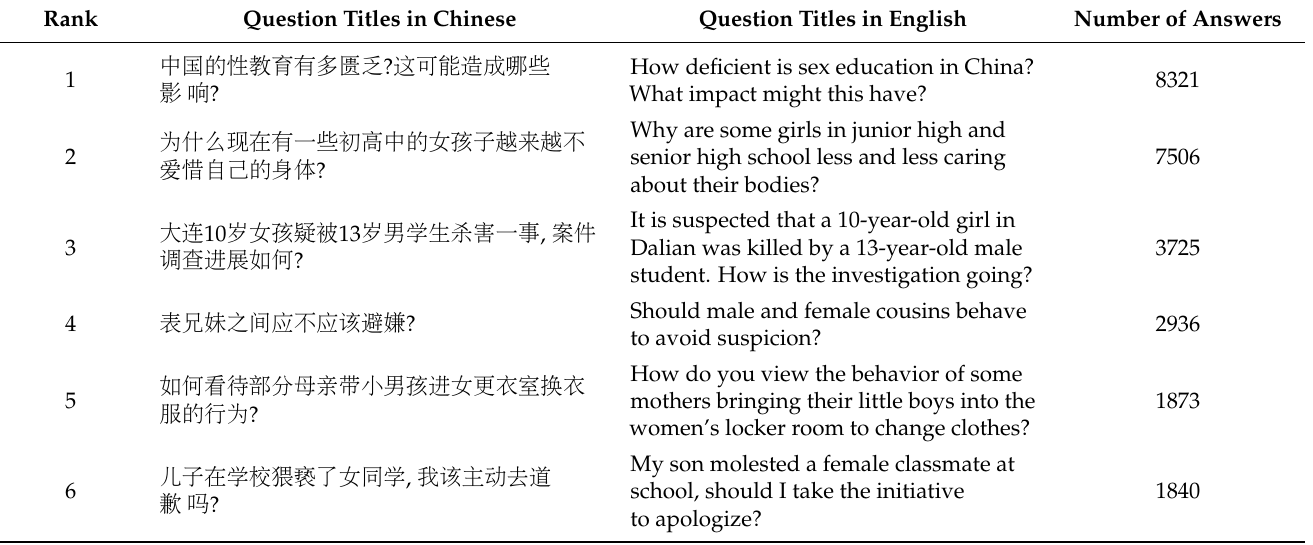
Table 1. Top 10 essential questions under the topic of “Sex Education” on Zhihu (in descending order of number of